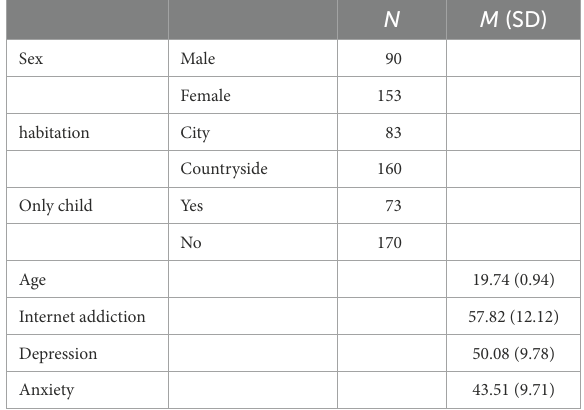
TABLE 1 Baseline descriptive statistics of demographics, depression, anxiety, and internet